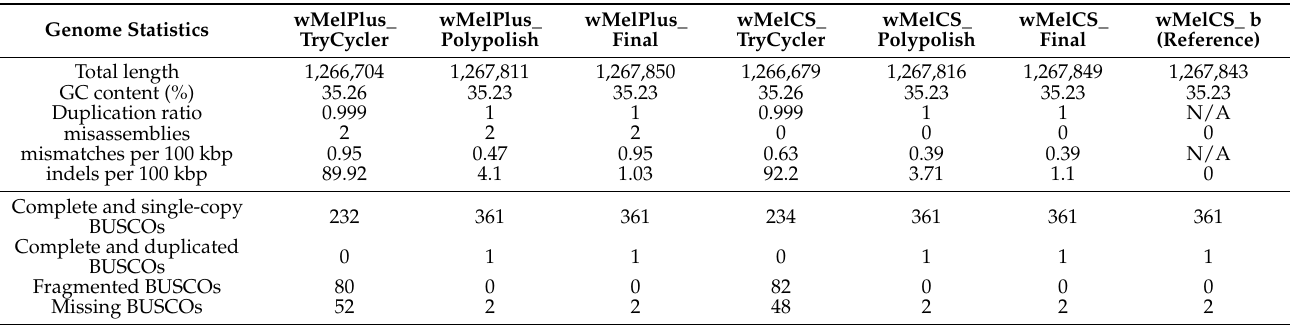
Table 1. Genome statistics of the resulting genomes obtained from hybrid assembling for both Wolbachia strains and a reference genome. BUSCO analysis has been performed using the Rick- ettsiales_odb10 data set.